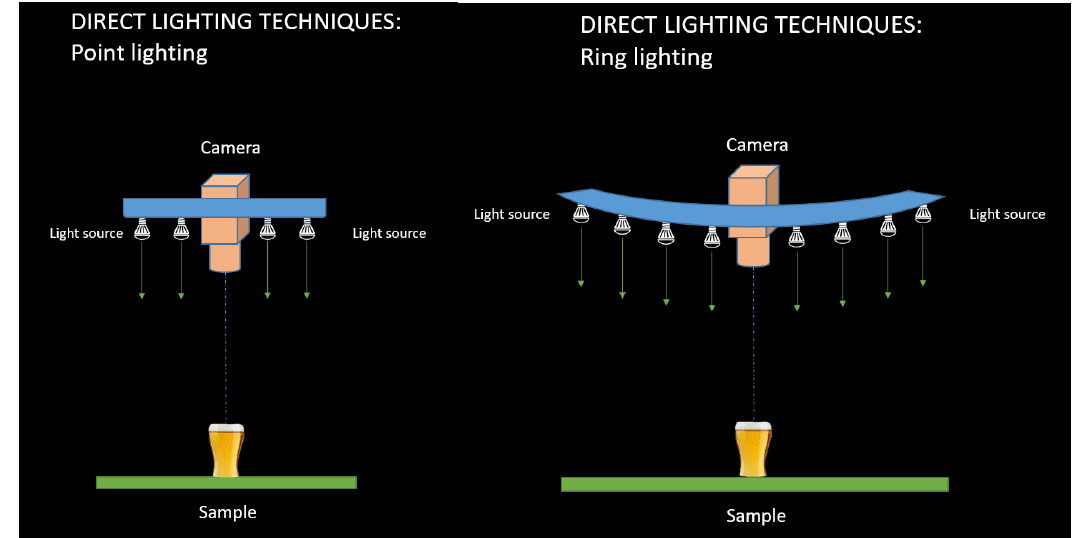
Figure 3. Direct lighting techniques—point and ring lighting.